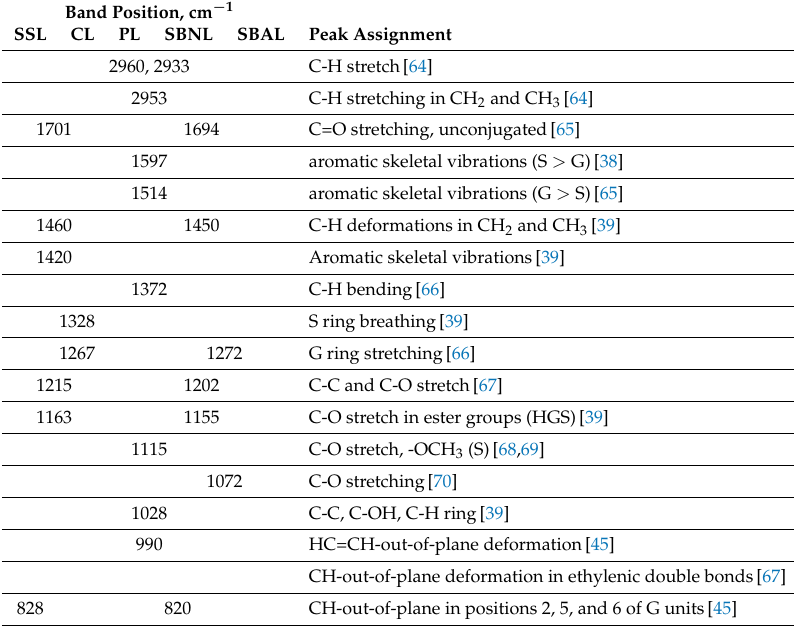
Table A1. Summary of FT-IR peak/band assignment for fractionated lignin samples. The abbreviations of lignin fractionated from pine sawdust (PL), cotton stalks (CL), sweet sorghum bagasse (SSL), spruce bark with (SBAL) and without acid addition (SBNL) were